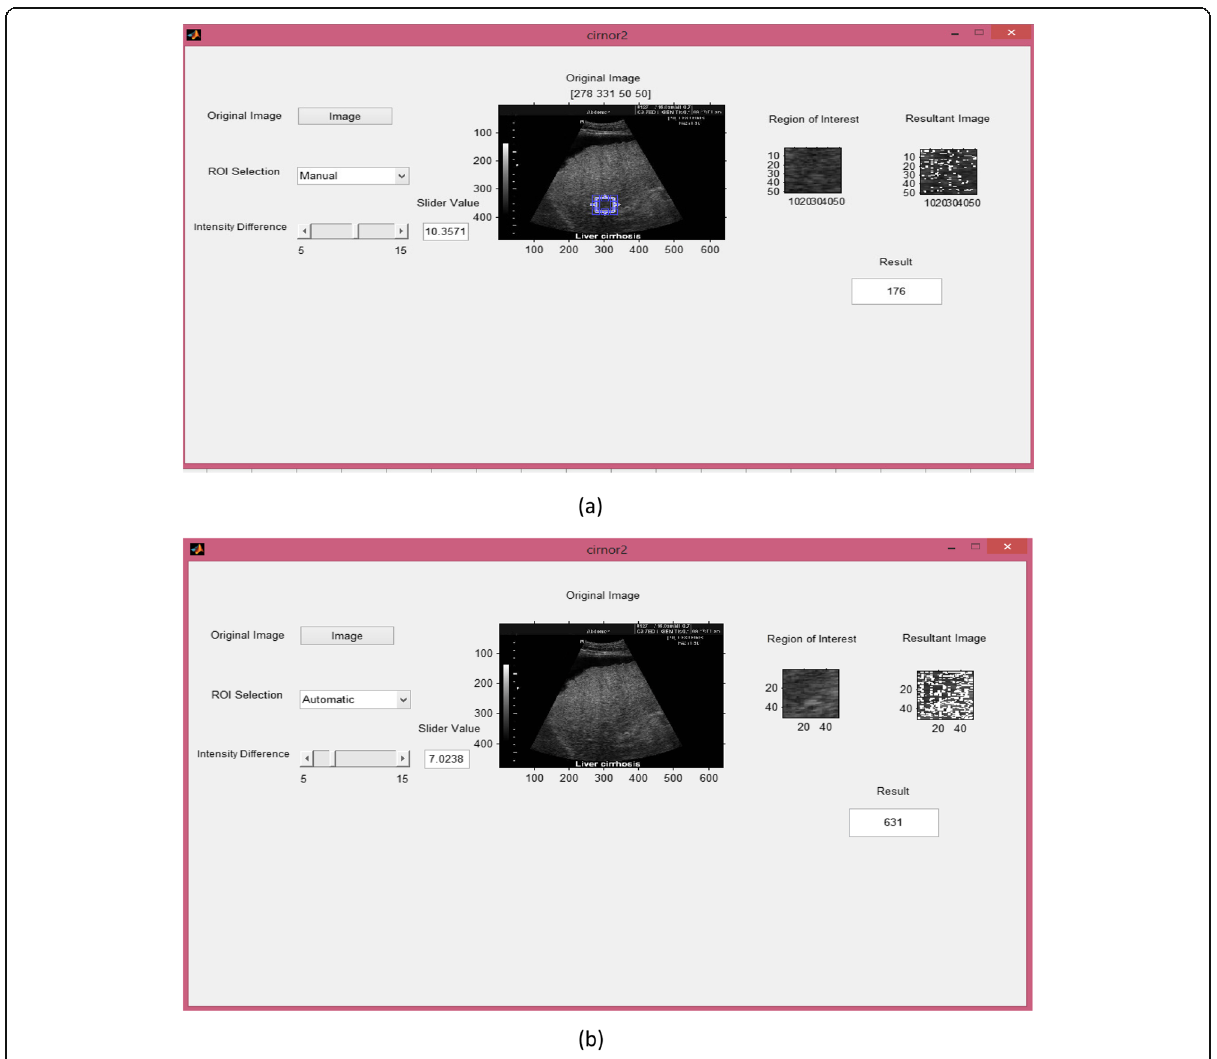
Fig. 4 a GUI for manual ROI selection. b GUI for automatic